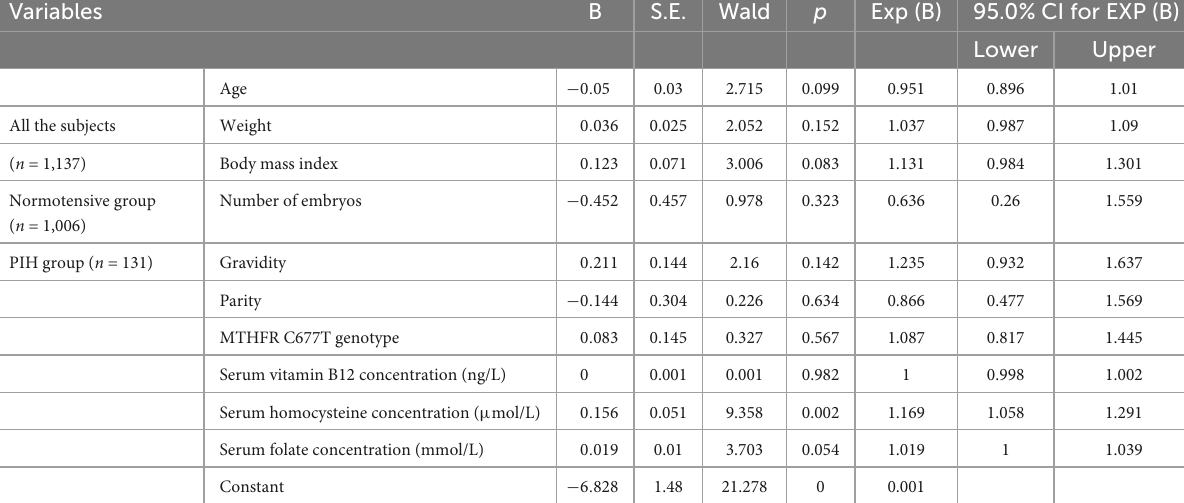
TABLE 2 Influence of general information and OCM-related indicators on PIH incidence based on logistic linear regression analysis*. Variables